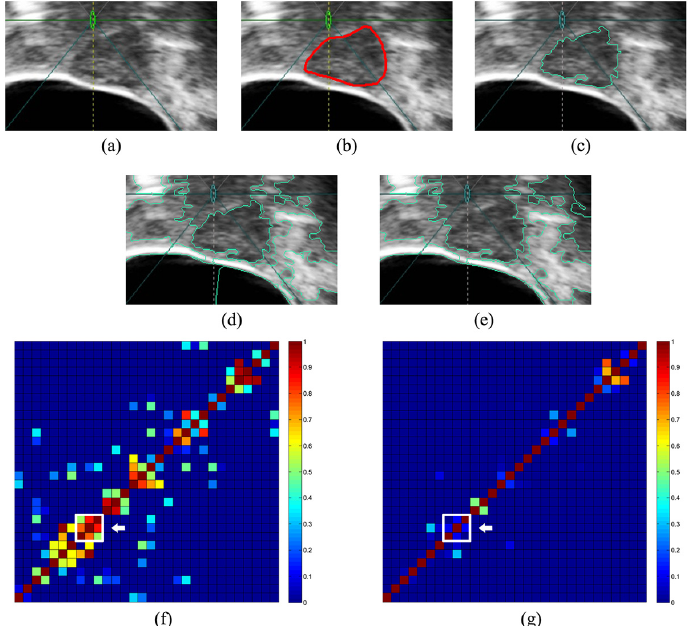
Fig 10. An example of a heterogeneous tumor. (a) The original image. (b) Standard boundary. (c) Boundary generated by the proposed method. (d) The merged result of the construction of W using the Quadratic-Chi histogram distance. (e) The merged result of the construction of W using the χ 2 distance. (f) Visualization of W using the Quadratic-Chi histogram distance. (g) Visualization of W using the χ 2 distance. The white arrow points to superpixels inside the